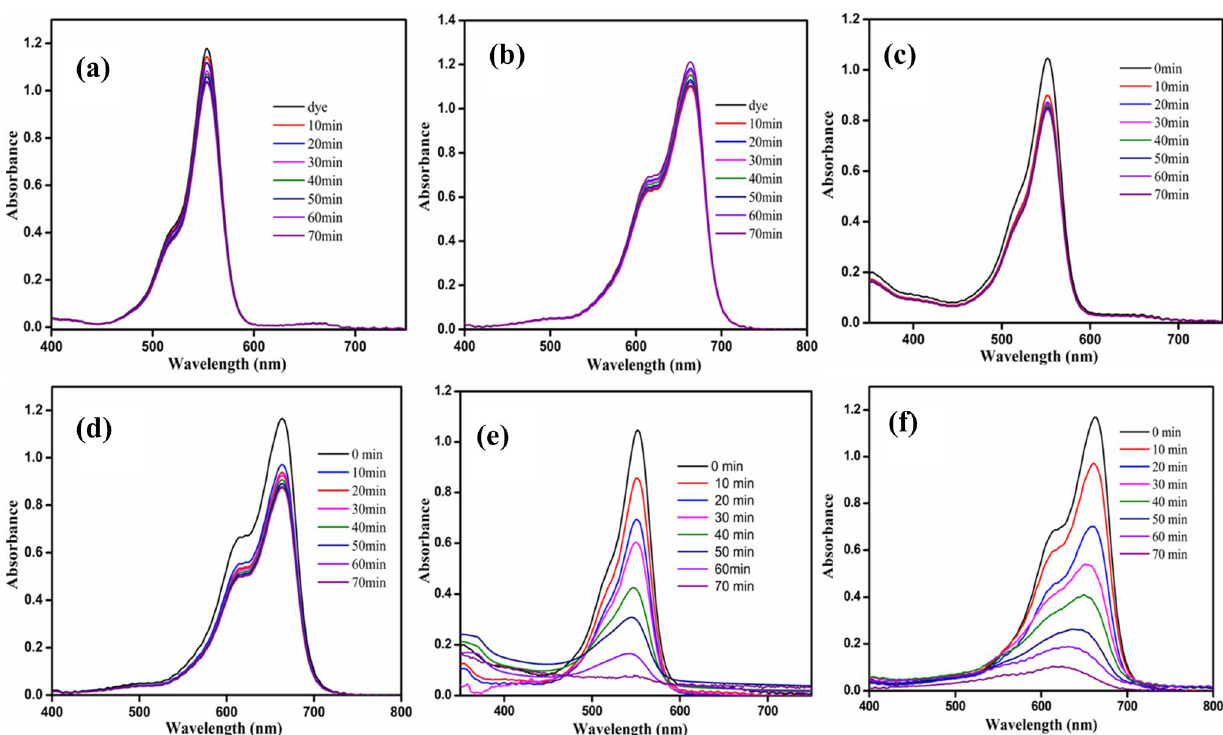
Fig. 12 Absorption study of ( a , b ) blank dye ( c , d ) dye absorption in dark and ( e , f ) degradation of MB and Rh-B